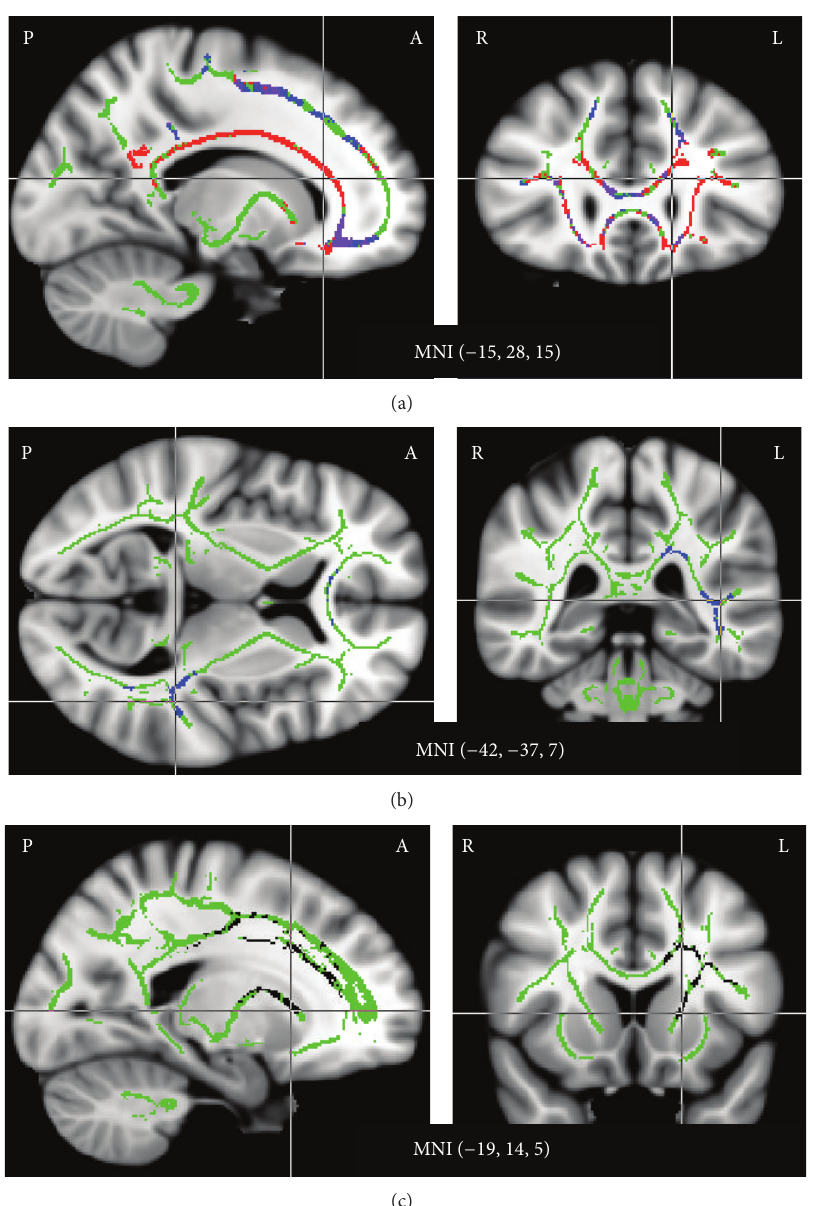
Figure 2: Correlations between FA/MD and age (a), hearing loss (b), and tinnitus loudness (c) . (a) Many voxels of the average WM skeleton (green), especially in frontal cortex and the corpus callosum, showed a significant ( 𝑃 < 0.05 , corrected) positive correlation between age and MD (red), a significant negative correlation between age and FA (blue), or both (purple). (b) In addition, several voxels in the WM tracts near left auditory cortex and in the WM tracts connecting left ACx to the corpus callosum showed a significant negative correlation between average hearing loss and FA (blue). This negative correlation was also observed in anterior portions of the corpus callosum. (c) Significant negative correlations (black) were also observed between tinnitus loudness ratings and MD in the anterior thalamic radiation and the anterior and superior left corona radiata. Results are superimposed on the MNI152 brain